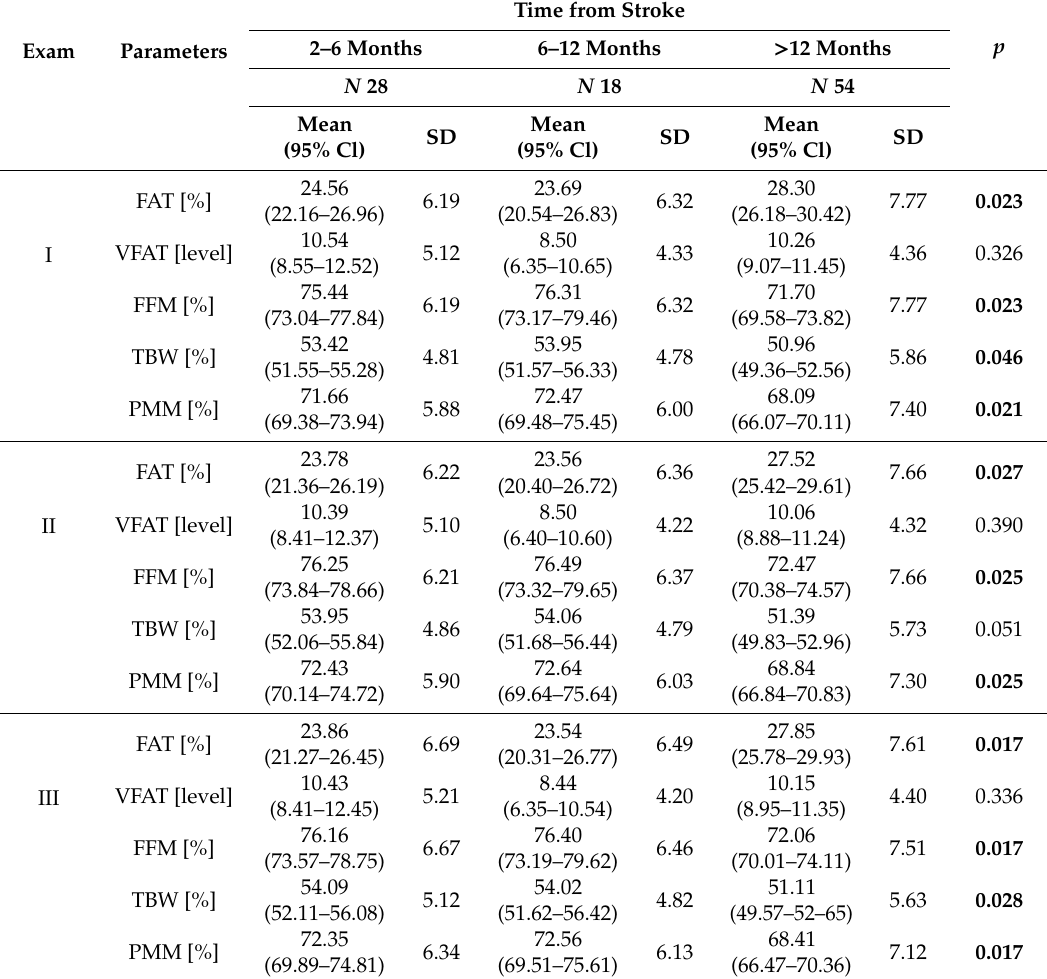
Table 4. Body mass components versus time from onset of the first stroke